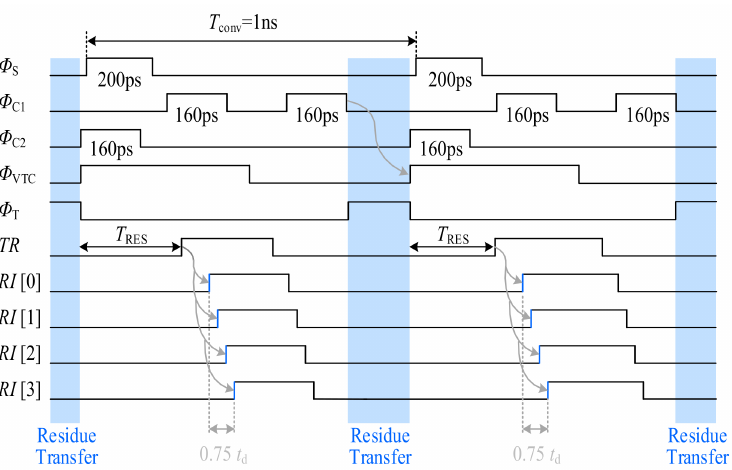
Figure 2. Timing diagram of the proposed two-stage